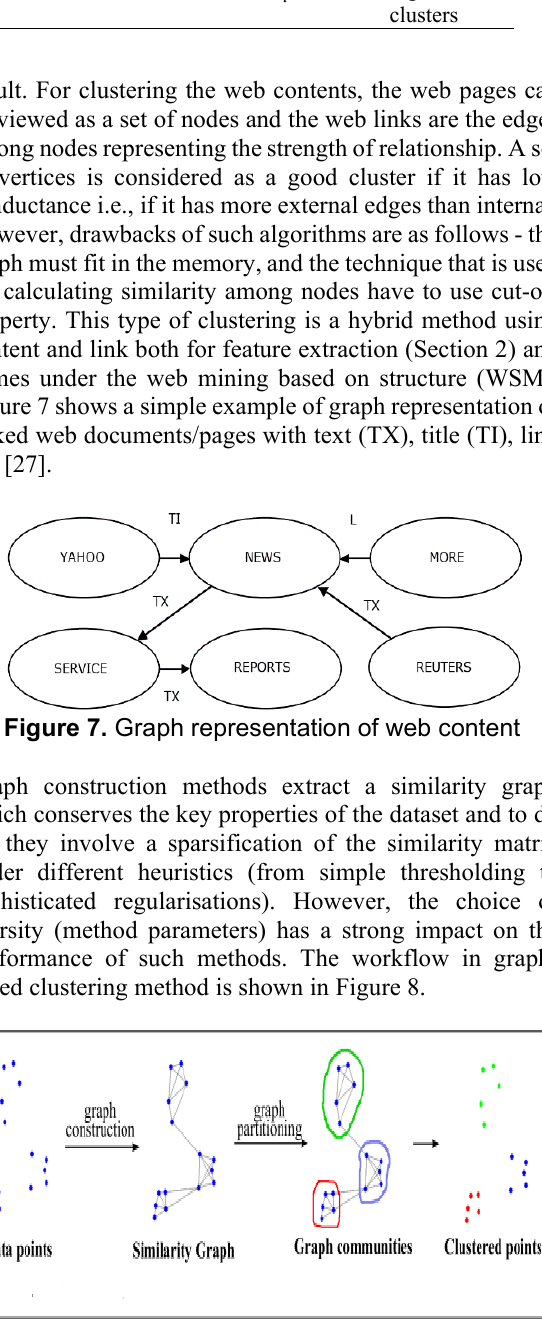
Figure 8. Basic idea of Graph-based clustering